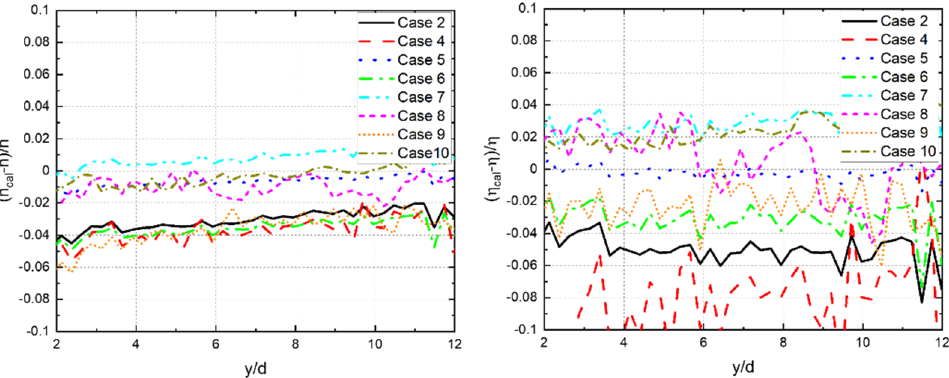
Figure 11. Errors of calculated span-wise averaged heat transfer coefficient and film cooling effectiveness at M = 1.0.